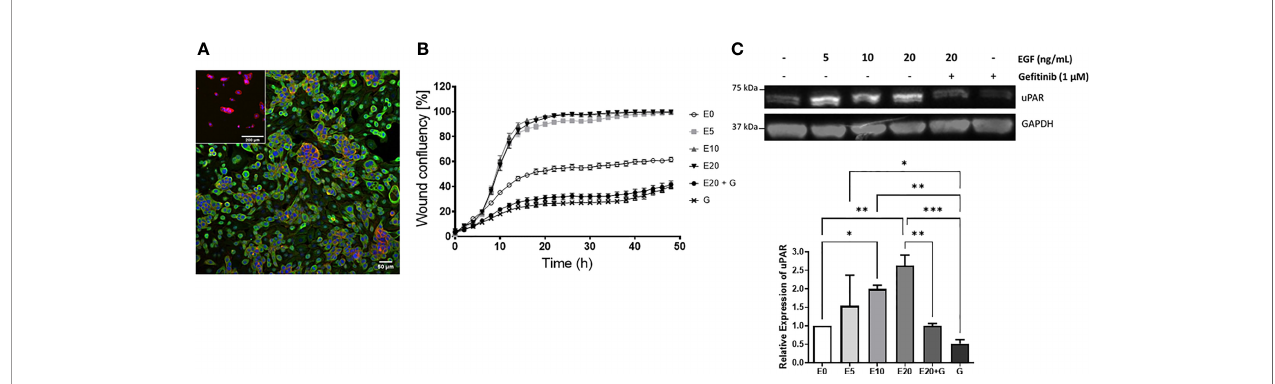
FIGURE 6 | EGF upregulation of cSCC cell line motility and uPAR expression. (A) Immunocytochemical image of UW-CSCC2 cells stained with anti-EGFR antibody (green) or anti-mouse IgG negative control (inset) and counterstained with RedDot (blue) and ActinRed 555 (red). (B) Representative in vitro scratch wound healing assay showing effect of EGF E ± EGFR inhibitor ge fi tinib G on simple migration of UW-CSCC2 cells. Values shown are mean ± SEM, n = 5; all treatment groups were signi fi cantly different from untreated controls p -value < 0.05, all ge fi tinib treatment groups signi fi cantly different to EGF only treatment groups p -value < 0.001; ordinary one-way ANOVA with Dunnett ’ s post-test. (C) Representative Western blot (right panel) demonstrating UW-CSCC2 uPAR levels in response to 24-h pretreatment with EGF ± ge fi tinib, at concentrations shown. Panel below: densitometry analysis showing the ratios of uPAR/GAPDH (used as a total protein loading control) for each treatment relative to no EGF control. Signi fi cance values are shown with * p -value < 0.05; ** p -value < 0.01; *** p -value <